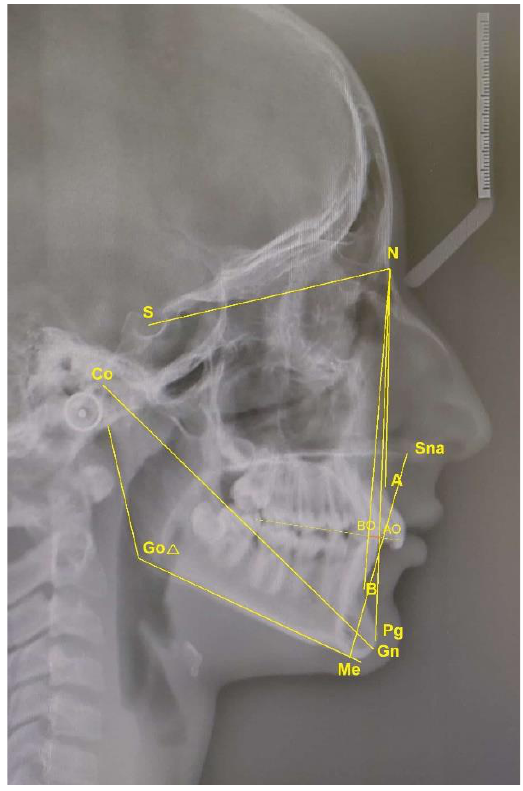
Figure 1. The angular and linear skeletal measurements. Legends: SNB: the angle formed between the SN plane and the point B indicates the relationship of the mandibular basal arch to the anterior cranial base; SNPg: the angle formed between the SN plane and the point Pg; ANB: the difference between SNA and SNB angle relates jaws to anterior cranial base; Wits appraisal: linear distance between the projecting points A and B perpendicular on the functional occlusal plane (AO and BO) indicates the skeletal sagittal jaw relationship; Gonial angle: the angle between the poste- rior tangent line of the ramus and the mandibular plane; LAFH: Lower anterior face height is the distance between points Sna and Me; CoGn: the linear distance between the con- dylion and the gnathion points indicates the mandibular length